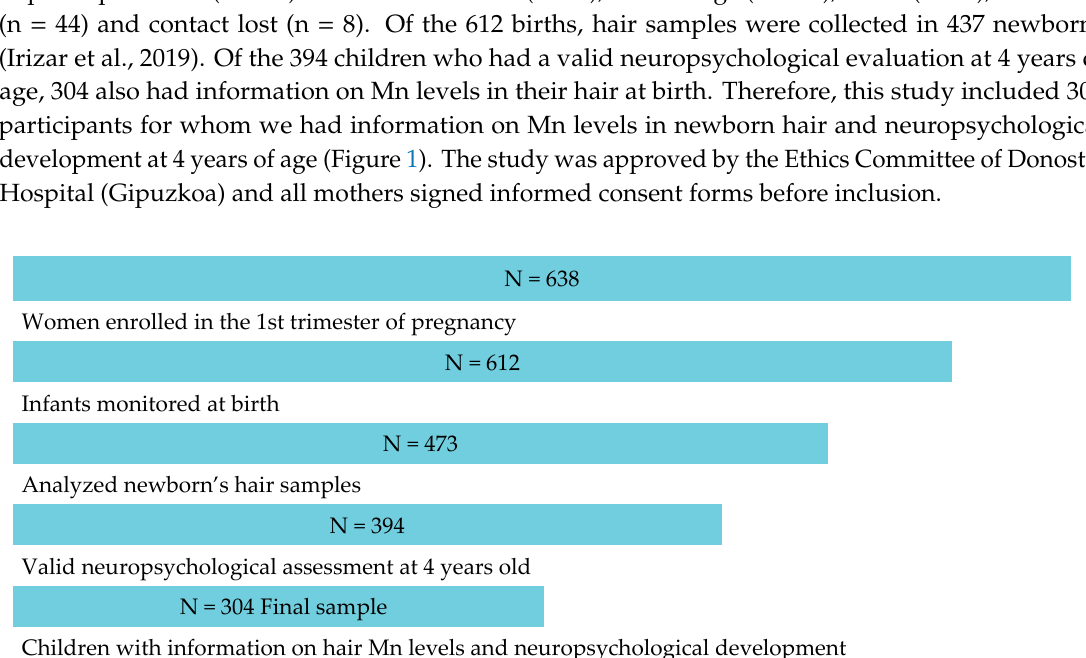
Figure 1. Flow of participants through the study and final sample .